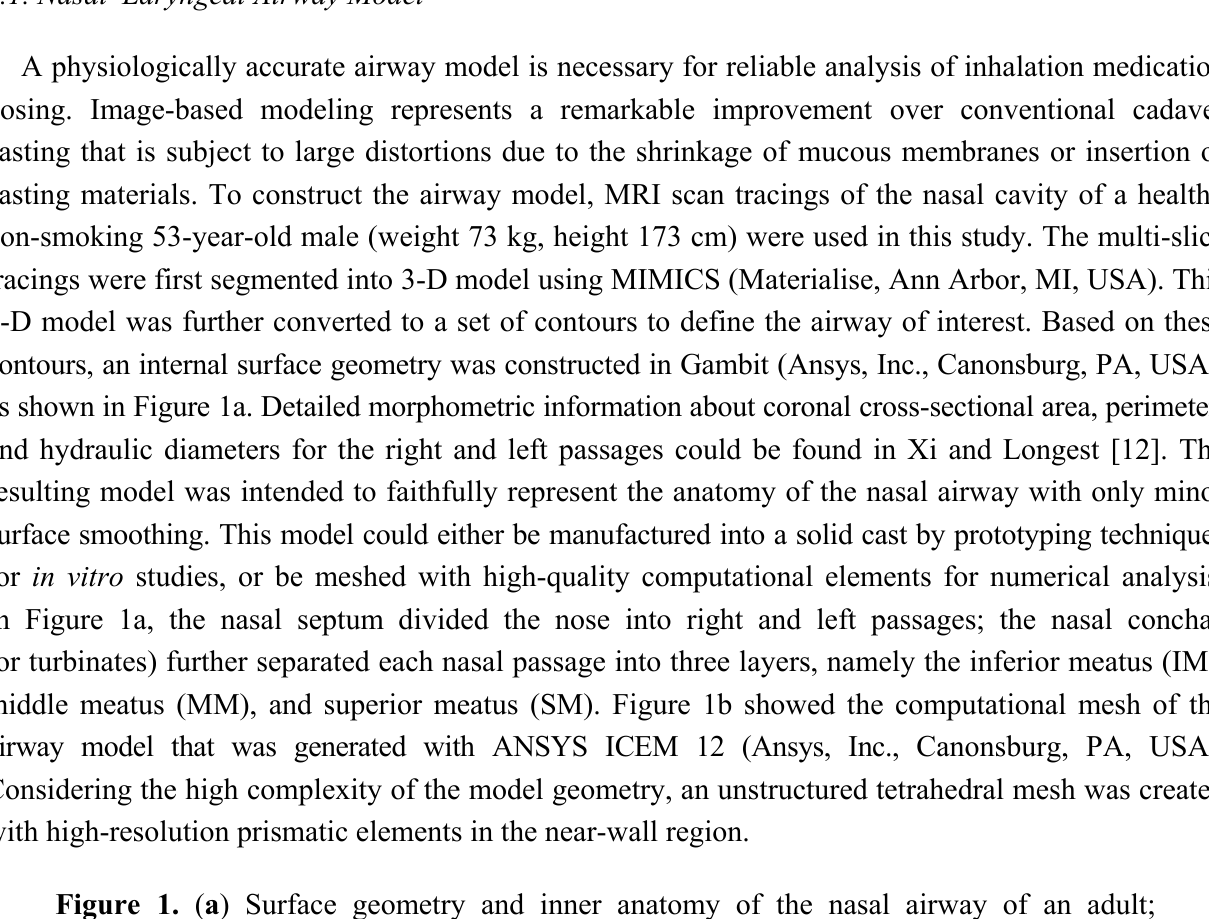
Figure 1. ( a ) Surface geometry and inner anatomy of the nasal airway of an